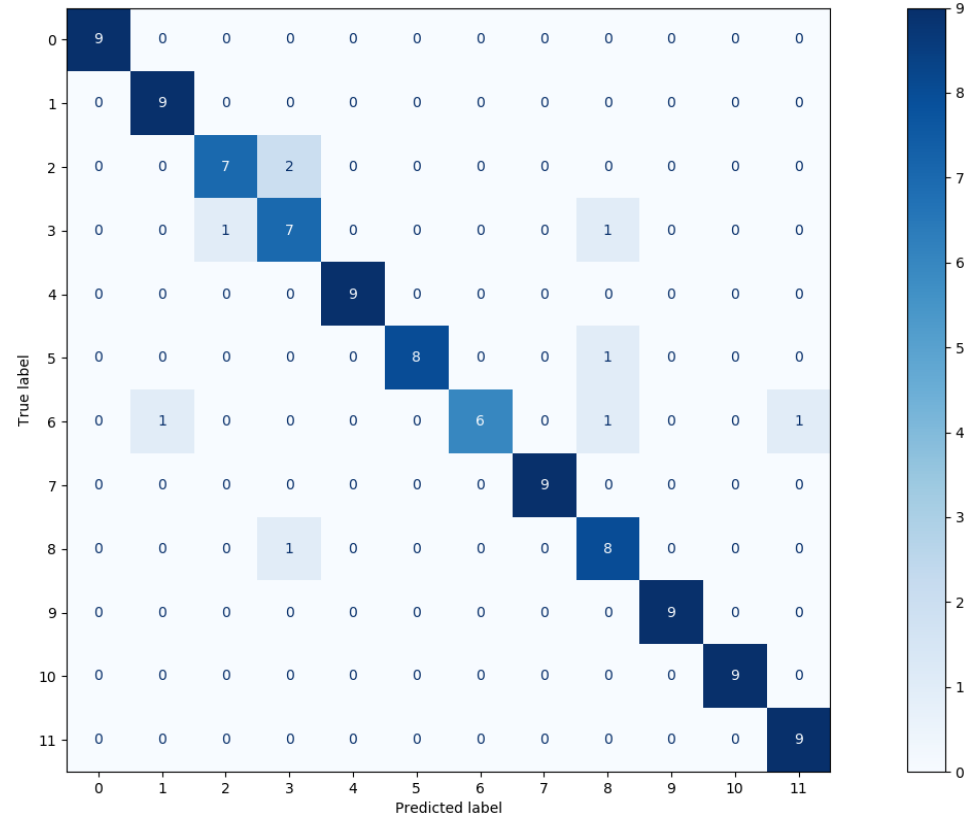
Figure 14. Confusion matrix of the hybrid two-layer LSTM trained on